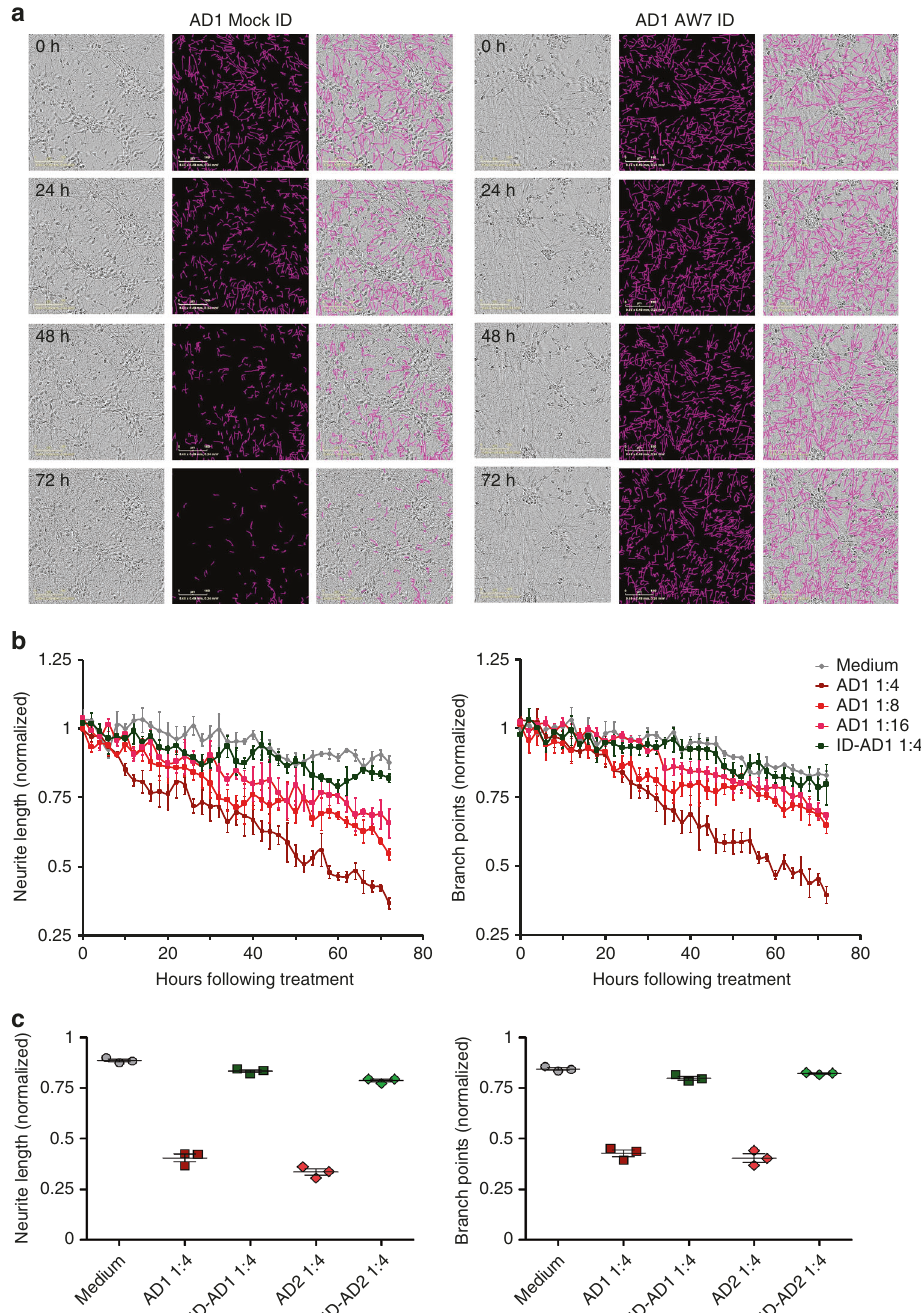
Fig. 5 Treatment of iNs with AD brain-derived soluble A β induces neuritic dystrophy. Live-cell imaging was used to monitor the effect of A β -containing AD brain extracts on iNs. a iN day 21 cultures were treated with mock-immunodepleted AD1 extract (Mock ID) or AD1 extract immunodepleted with the pan anti-A β antiserum AW7 (AW7 ID) and cells imaged for 72 h. Phase contrast images (left panels) at 0, 24, 48, and 72 h were analyzed using the IncuCutye NeuroTrack algorithm to identify neurites (middle panels) and the NeuroTrack-identi fi ed neurites (pink) are shown superimposed on the phase contrast image (right panels). Scale bars are 100 μ m. b Each well of iNs was imaged for 6 h prior to addition of sample and NeuroTrack-identi fi ed neurite length and branch points used to normalize neurite length and branch points measured at each interval after addition of sample. Mock-ID AD1 extract was tested at 3 dilutions, 1:4, 1:8, and 1:16. Immunodepleted AD1 was tested at 1:4 and cells treated with medium alone were used to monitor the integrity of untreated cells. The values shown in graphs are the average of triplicate wells for each treatment ± SEM. c Plots of normalized neurite length (left panel) and neurite branch points (right panel) are derived from the last 6 h of the traces shown in b and in Supplementary Figure 8B and are presented as mean values ± SEM. Application of AD1 brain extract caused a decrease in both neurite length and branch points relative to: (i) the same neurons prior to treatment, and (ii) sister wells of untreated neurons (neurite length, p < 0.0001; branch points, p < 0.0001, two-way ANOVA). Importantly, AD1 extract that had been immunodepleted of A β had no signi fi cant effect on either neurite length or branch points (neurite length, p = 0.7195; branch points, p = 1.0000, two-way ANOVA). The results shown are representative of at least three independent